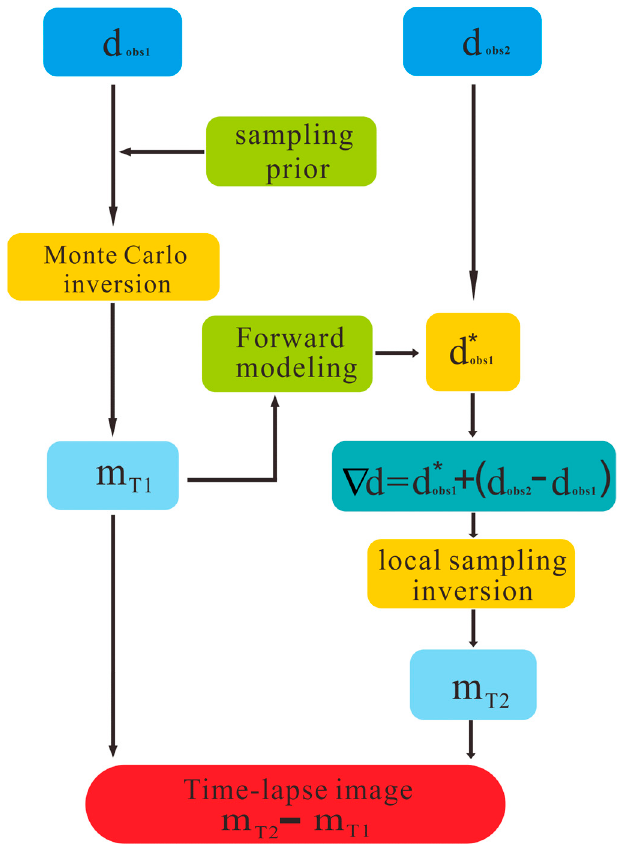
Figure 1. The double difference strategy. d obs 1 , d obs 2 are the corresponding observational data at different times T 1 , T 2 . The models m T 1 and m T 2 are the inversion result at time T 1 , T 2 . The result of time-lapse inversion can be obtained by subtracting m T 1 from m T 2